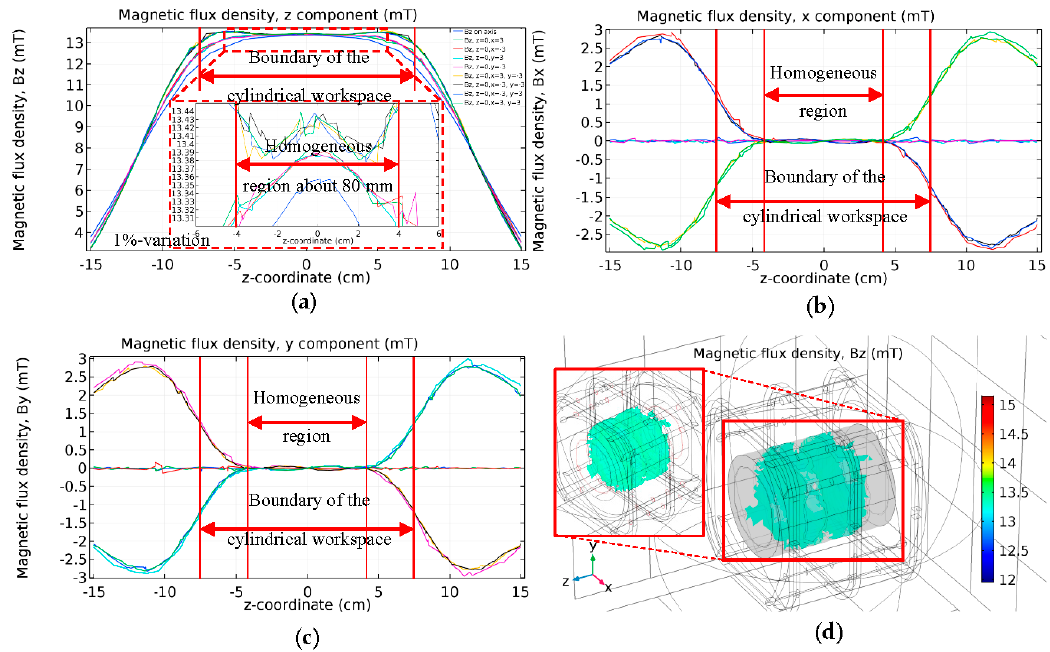
Figure A2. Magnetic field generated by the z-coils with magnitude of on and off-z-axis. ( a ) Magnetic field in the z-direction. The hidden-line red box emphasizes 1%-variation of magnetic field. ( b ) Magnetic field in the y direction. ( c ) Magnetic field in the x direction. ( d ) 3D graphic of Homogeneous region of magnetic field generated by the z-coils over the whole workspace, represented by the blue color.